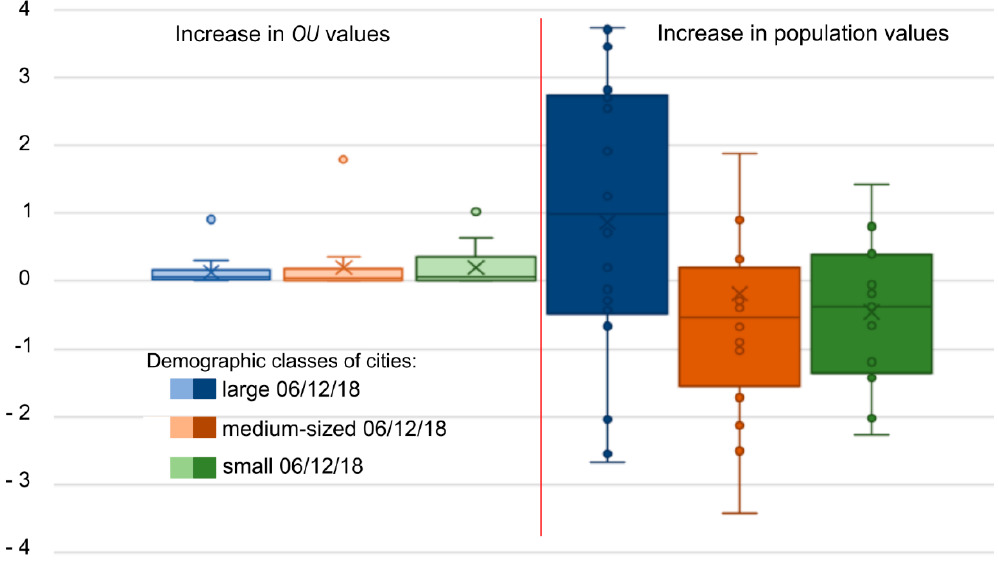
Figure 12. Increase in OU values and population in 2012–2018.